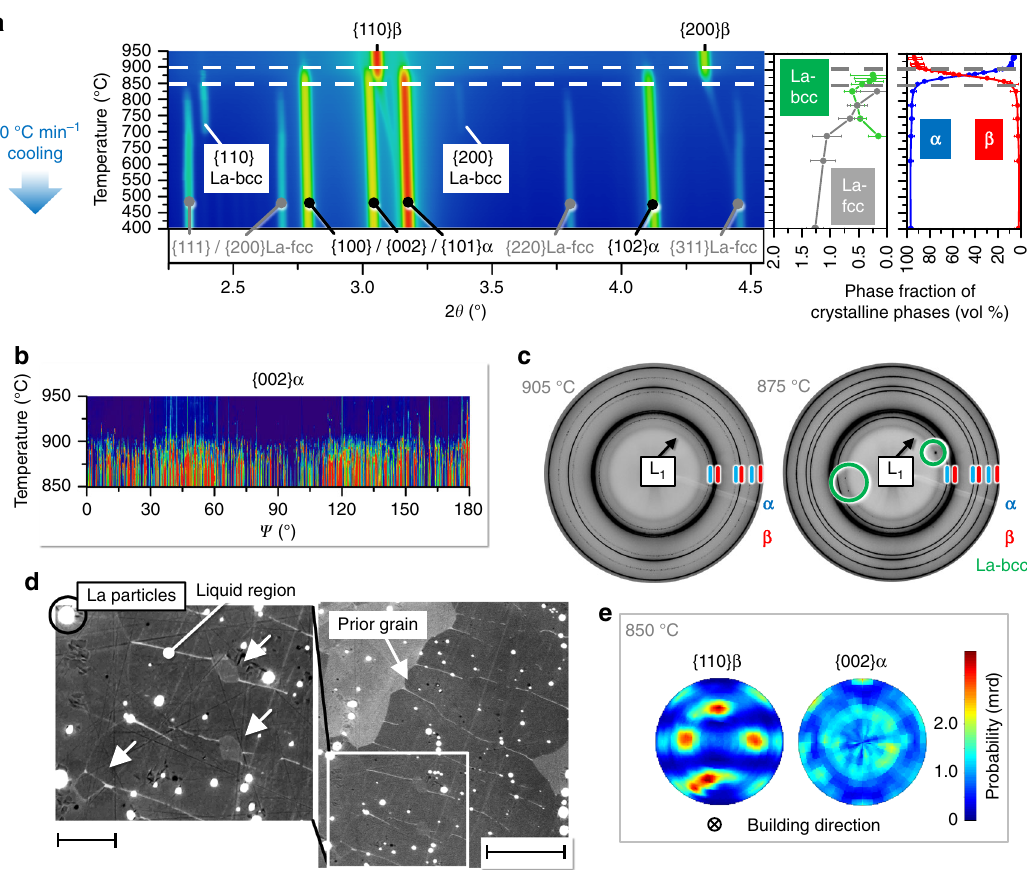
Fig. 4 Phase transformation kinetics of the Ti-2wt.% La alloy. Formation of α starts in the L 1 + β fi eld and, subsequently, α transforms from β during cooling. a Color-coded 2D plot of the evolution of {hkl} re fl ections of β , α , La-bcc and La-fcc for a representative 2 θ range of 2.25 – 4.55°, combined with the simultaneous evolution of volume fractions of crystalline phases obtained from Rietveld analysis during continuous cooling from 950 °C down to 400 °C with 20 °C min − 1 . No changes are observed for T < 400 °C. b Color-coded 2D plot of the evolution of {002} α Bragg re fl ections for an azimuthal angle ( ψ ) range 0 – 180° during continuous cooling between 950 – 850 °C with 20 °C min − 1 . c Presence of α coexisting with β and L 1 phases during transformation is revealed in the complete Debye-Scherrer rings acquired at 905 °C and 875 °C. d Nucleation of α particles (pointed by arrows) at former β /L 1 interfaces is visible in a microstructure quenched from 950 °C. Scale bar, 5 μ m (right side); 2 μ m in magni fi ed image (left side). e Normalized pole fi gures of {110} β and {002} α reconstructed from a gauge volume of 1 × 1 × 5 mm 3 , indicating that α does not inherit the texture of the parent β phase right after β → α transformation of Ti-2La during cooling down to 850 °C. The transformation of α from β ( β → α ) is re fl ected in the rapid increase in the volume fraction of α between 900 – 850 °C shown in